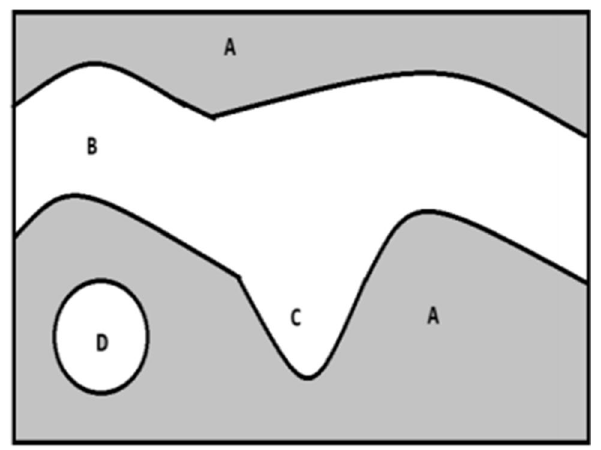
Fig. 1 Distribution of pore structure. (A → coal matrix, B → crack, C → open micropores, and D